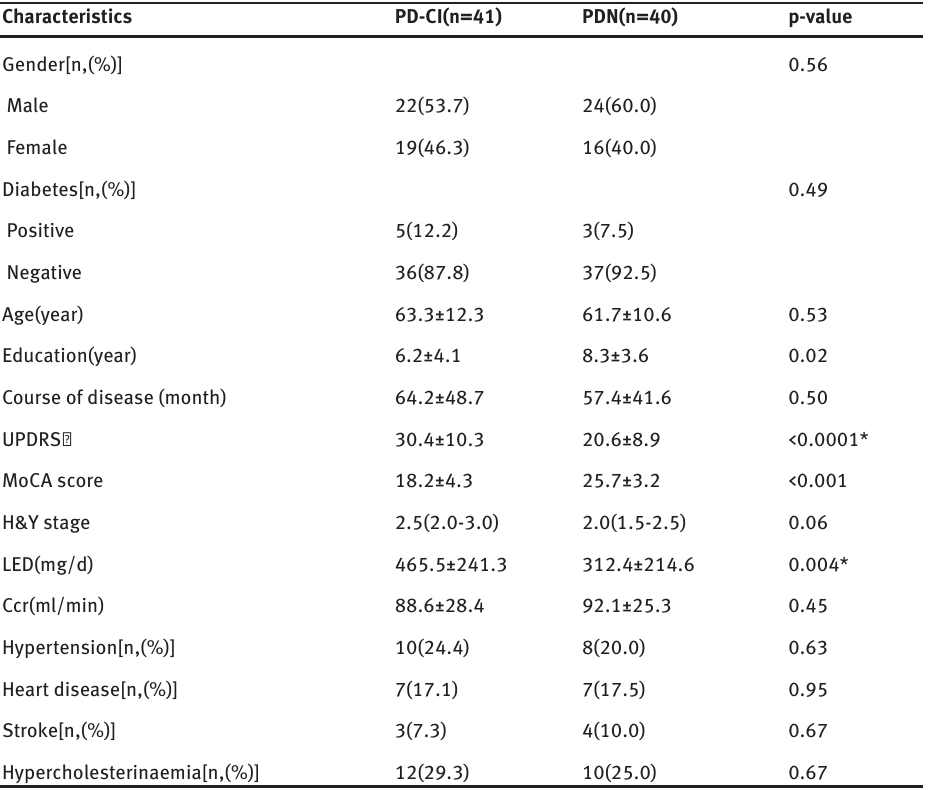
Table 1: The clinical characteristics and demographic features of the included PD-CI and PDN patients. Characteristics